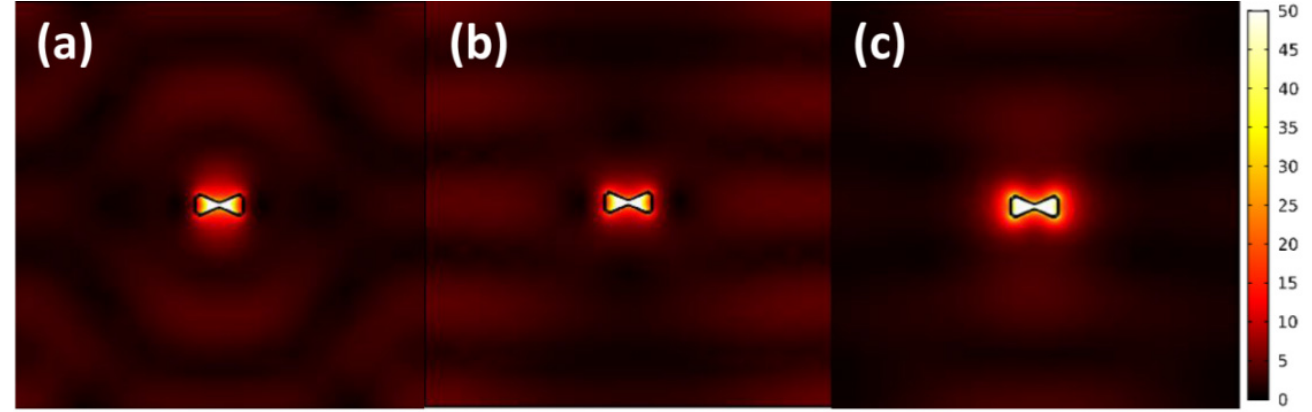
Figure 4. Intensity (| 𝐸 | 2 ) distribution on the half ‐ height surface of triple resonance substrate at ( a ) 766 nm, ( b ) 858 nm, ( c ) 932 nm. Table 1. Normalized effective mode volume, the quality factor and Q/ V eff for different resonance modes of bowtie nanoholes, and a single disk upon silica spacer and silver